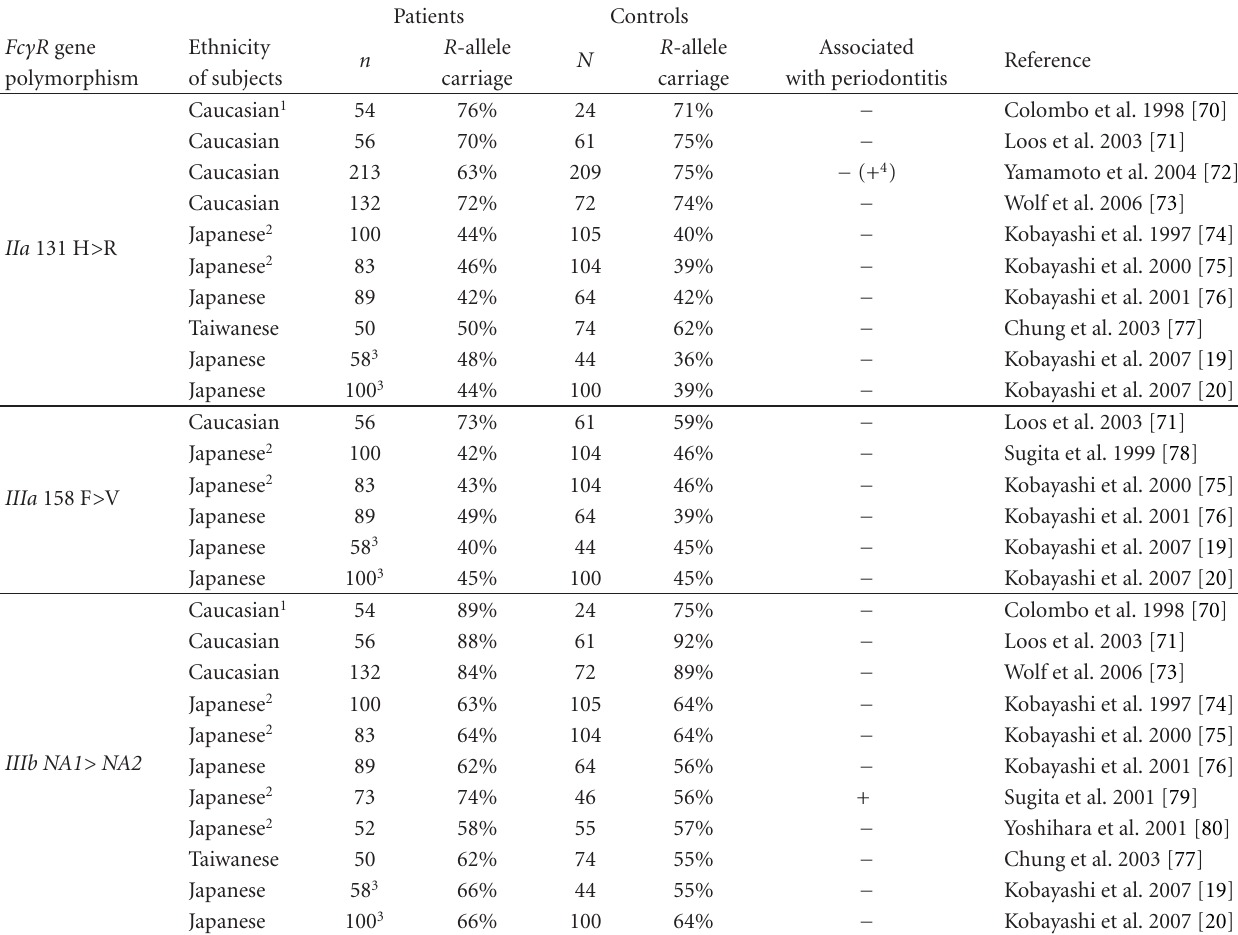
Table 9: Fc γ RIIa , Fc γ RIIIa, and Fc γ RIIIb gene polymorphisms and carriage rate of the Rare ( R )-allele in case-control studies and association with susceptibility to chronic